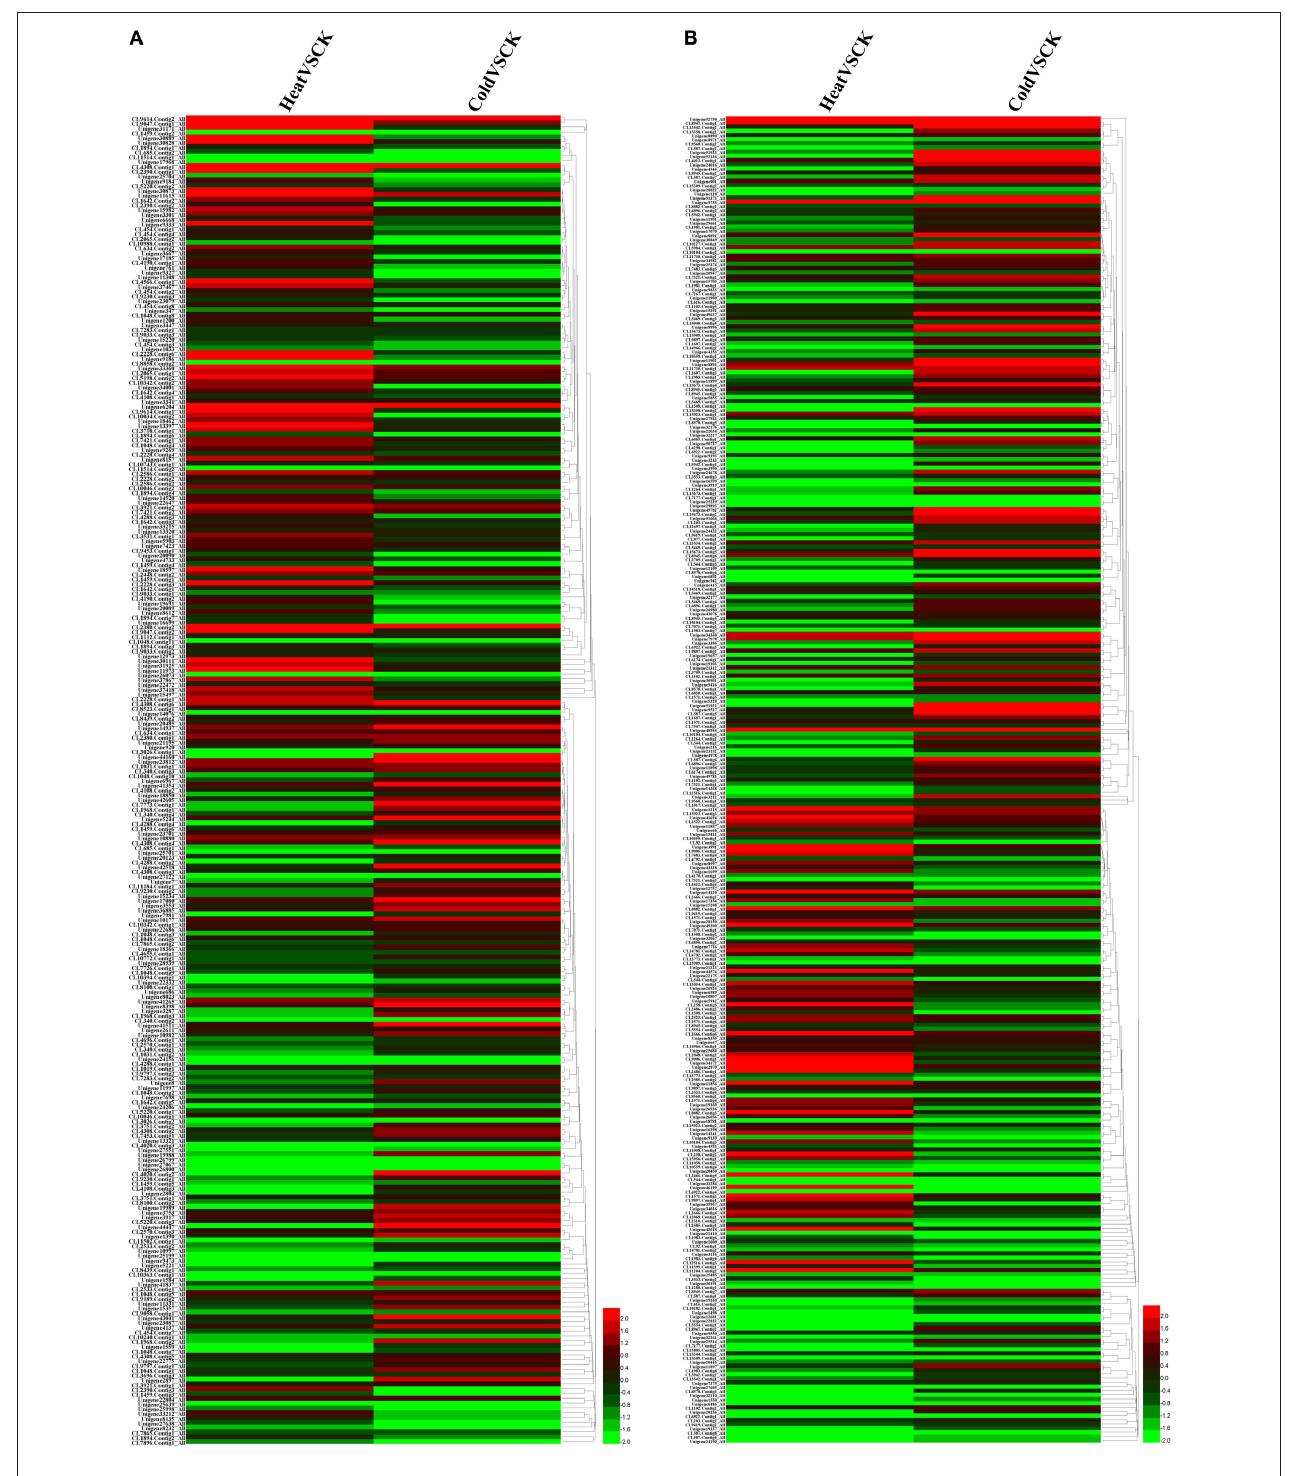
FIGURE 4 | Expression Heatmap of the Predicted P450 Transcripts. Heatmap was drawn according to log2FC values using HemI toolkit (Deng et al., 2014). Log2FC was calculated pairwise basing on the expression level for each P450 transcript. (A) Heatmap of P450 transcripts identified in perennial ryegrass. (B) Heatmap of P450 transcripts identified in tall